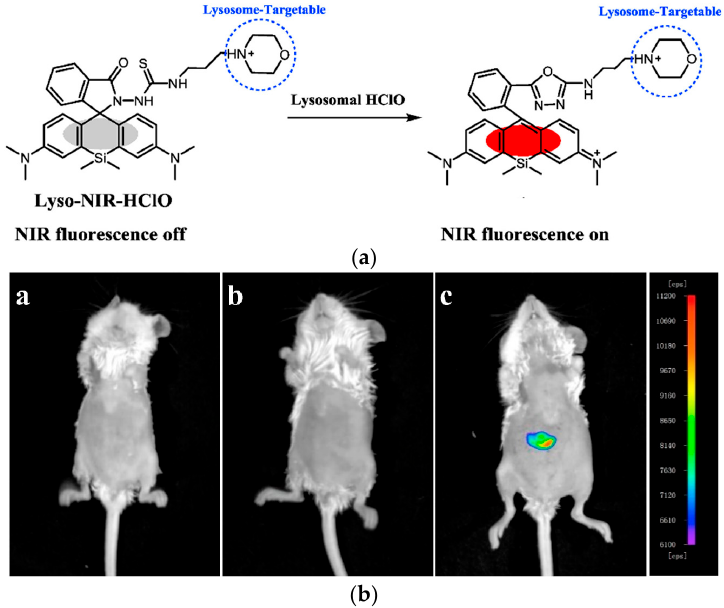
Figure 19. Detection of HClO in lysosomes: ( a ) The response mechanism of Lyso-NIR-HClO to lysosomal HClO; ( b ) Fluorescent images of in vivo HClO production from the peritoneal cavity of the mice with Lyso-NIR-HClO in inflamed mouse model: ( a ) negative control ( b ) Lyso-NIR-HClO ; ( c ) Lyso-NIR- HClO , LPS and PMA. Adapted with permission from [250].